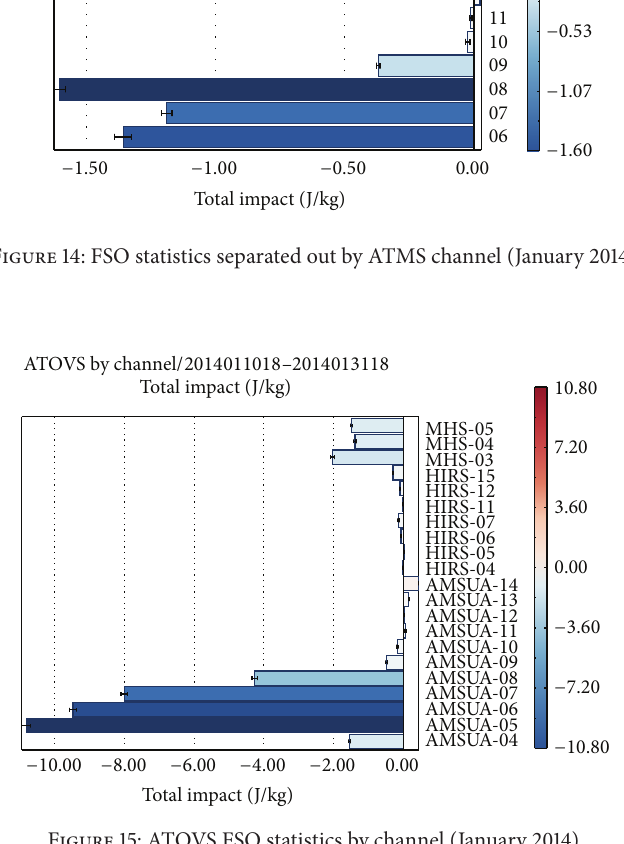
Figure 15: ATOVS FSO statistics by channel (January